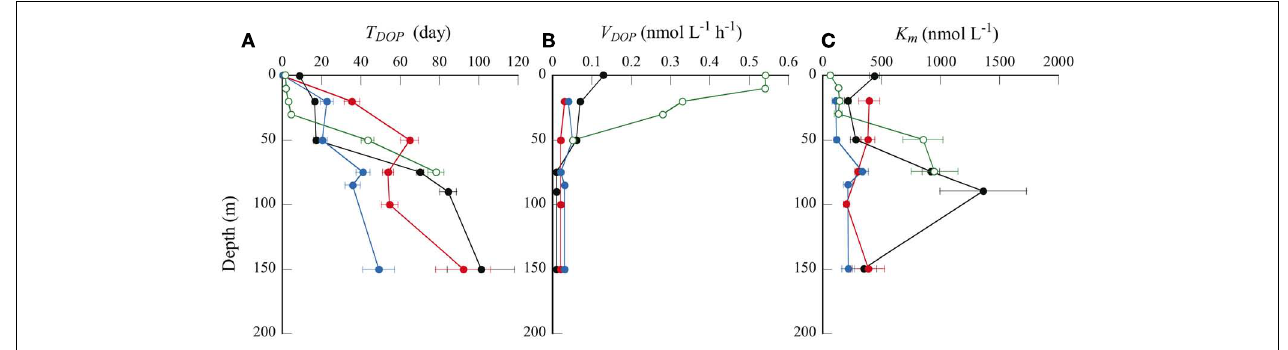
FIGURE 5 | Depth profiles of (A) T DOP , (B) V DOP , and (C) K m . Symbols are same as in Figure 2 .